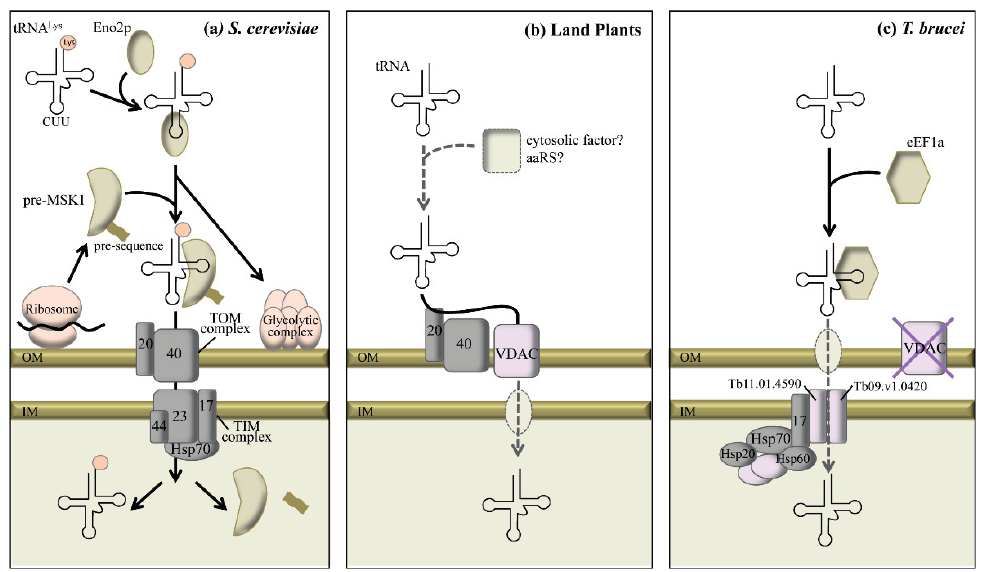
Figure 1. Comparative models showing the factors involved in tRNA import in mitochondria from ( a ) S. cerevisiae , ( b ) land plants and ( c ) T. brucei . Black arrows represent characterized steps of import, whereas grey dotted arrows represent tentative steps. OM and IM stand for mt-outer and inner membrane, respectively. TIM and TOM stand for translocase of the inner and outer mt-membrane. The subunits of TOM and TIM complexes are distinguished by their size given in kDa. Hsp describes different heat shock proteins, Eno2p stands for the glycolytic enzyme Enolase, aaRS for aminoacyl-tRNA synthetase, VDAC for the Voltage Dependent Anion Channel, pre-MSK1 for the precursor of the mitochondrial lysyl-tRNA synthetase, eEF1a for the eukaryotic translation elongation factor 1 alpha, and Tb for Trypanosoma brucei . Proteins shown in grey denote proteins belonging to the protein import machinery. Adapted from refs